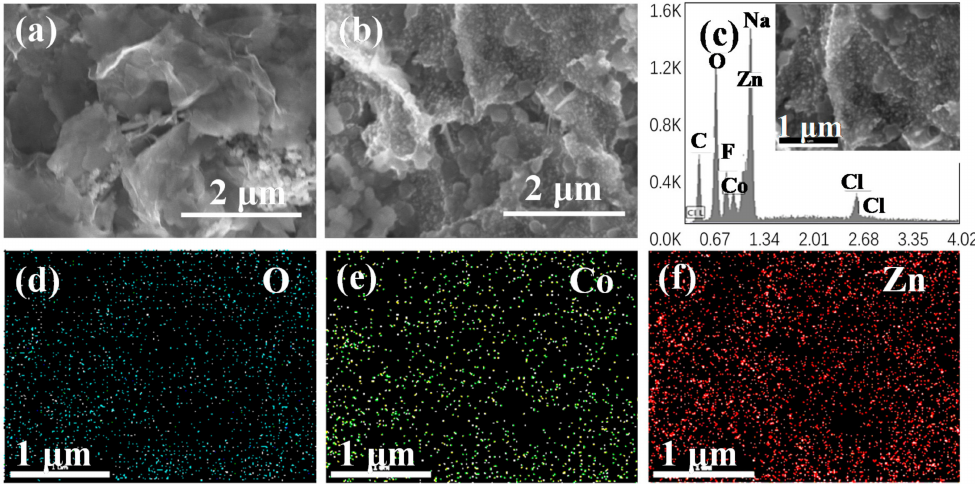
Figure 6. SEM image of the prepared electrode before ( a ) and after cycling ( b ); The EDS mapping results ( c – f ) of the electrode after 100 cycles in sodium ion